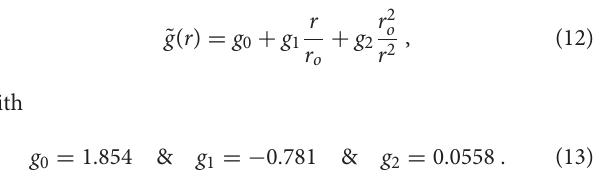
s / dr ) setting the temperature, density and thermal conductivity. For visualization purposes the relative ˜ 0.5, A SSL 1.0, Di 3.0, Ŵ = = = =